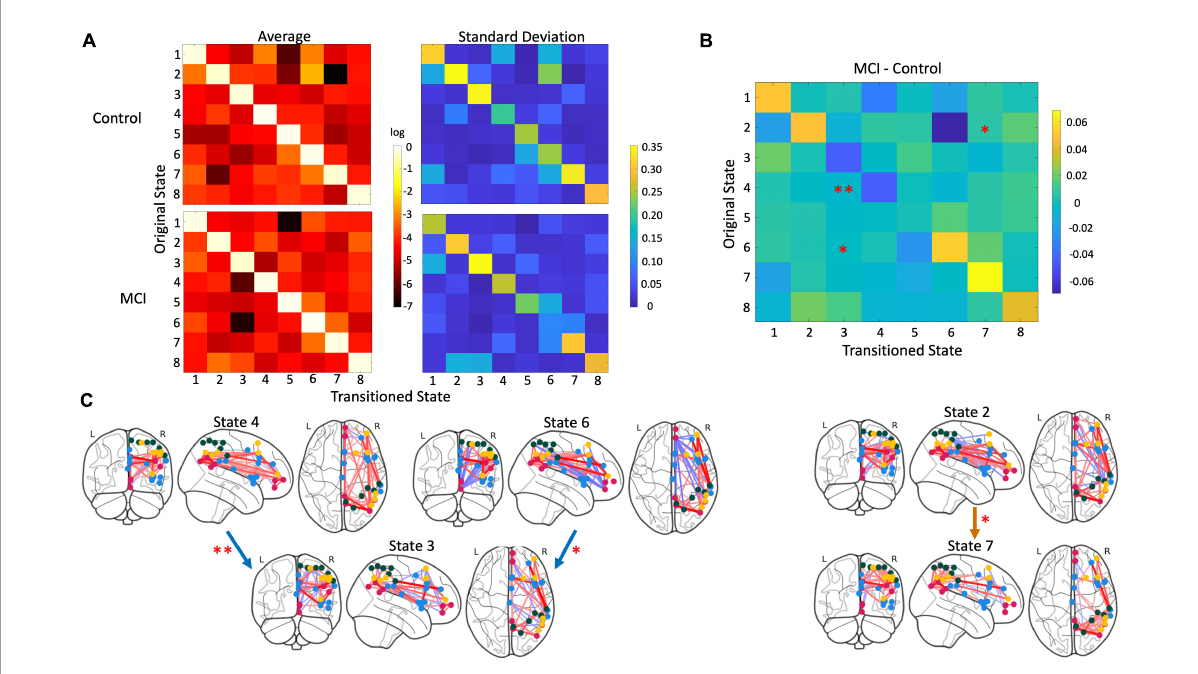
FIGURE4 Differences in state transition probability. (A) Matrices with a mean (left) and standard deviation (right) of the log-transformed transition probability i.e., how likely a participant moved from one state to another, with controls above and MCI participants below. (B) Three transitions were significantly different between groups: The transition from state 4 to state 3 ( p = 0.002), state 6 to state 3 ( p = 0.009), and state 2 to state 7 ( p = 0.04). MCI participants were less likely to switch from state 4 to state 3 and from state 6 to 3 than control participants. But MCI participants were more likely switch from state 2 to 7 compared to controls. (C) Glass brain plots of significant transitions with blue arrows indicating transitions controls were more likely to take and orange arrows indicating transitions MCI participants were more likely to